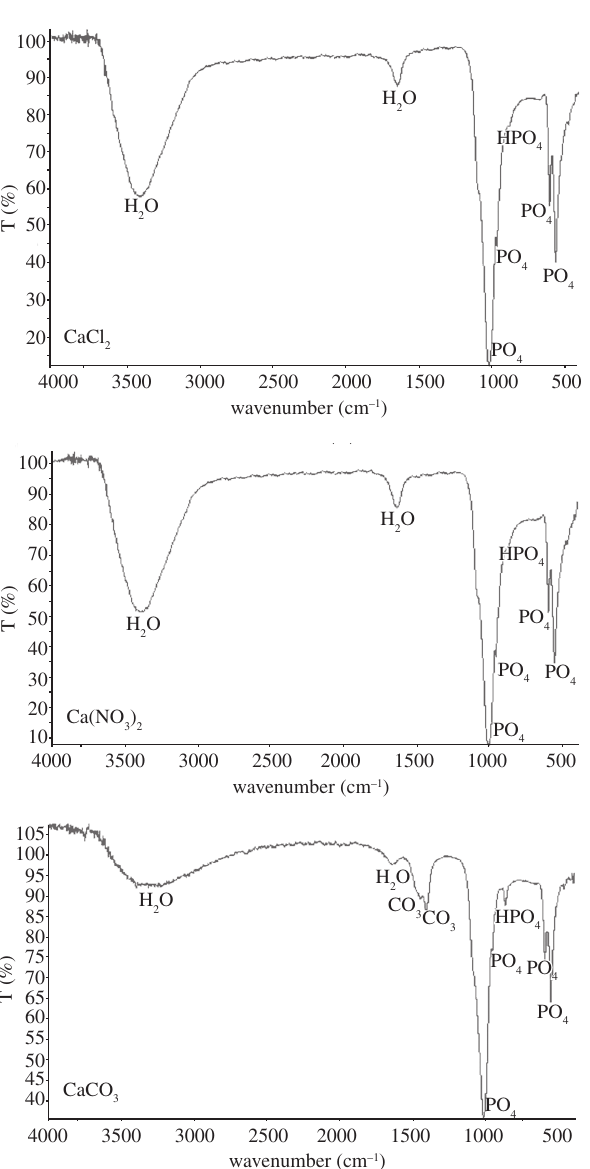
Figure 4. XDR pattern of carbonated oxygenated apatite after calcination at 900 °C for 2